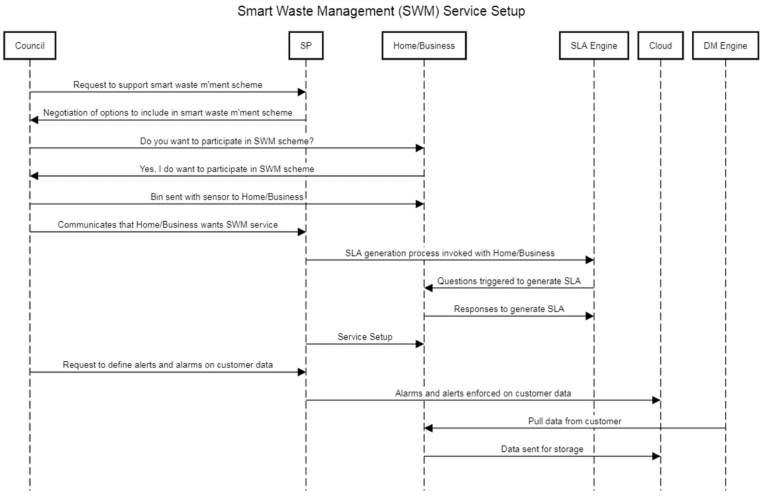
Figure 2. Smart waste management service setup